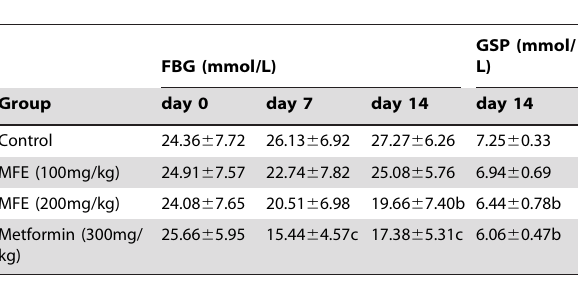
Table 3. Effect of the MFE on the Fasting Blood Glucose (FBG) and Glucosylated Serum Protein (GSP) of STZ-induced Diabetic Mice. a